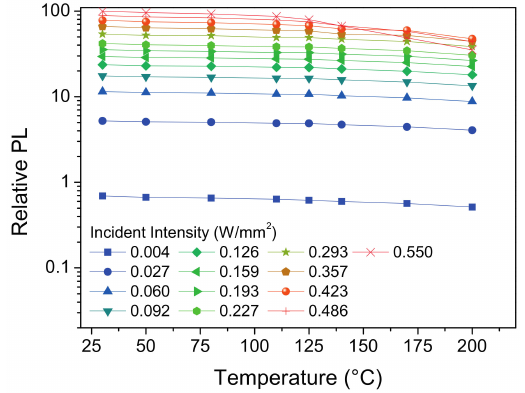
Figure 5. Semilog plot of the relative photoluminescence signal of the YAG:Ce phosphor as a function of carrier temperature and at different incident